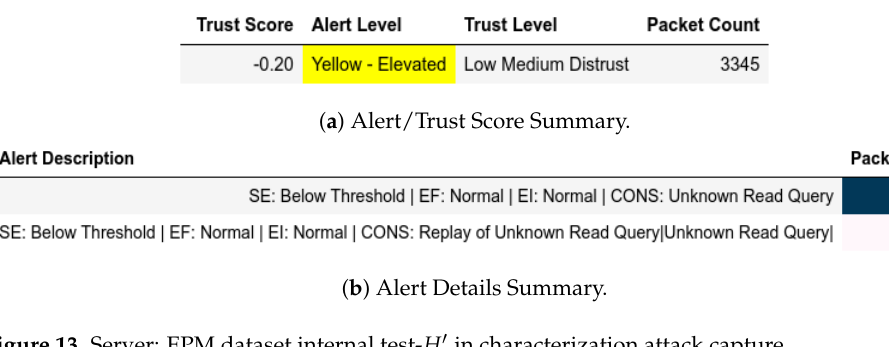
Figure 13. Server: EPM dataset internal test- H (cid:48) in characterization attack